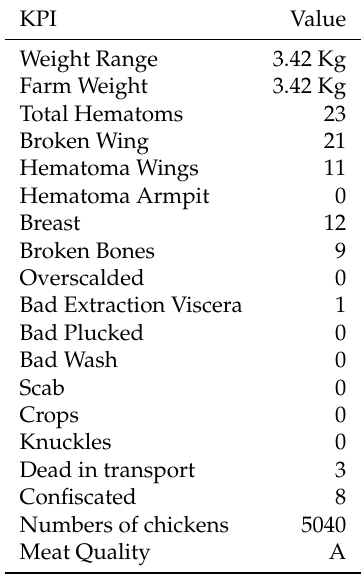
Table 4. KPI results obtained in slaughterhouse